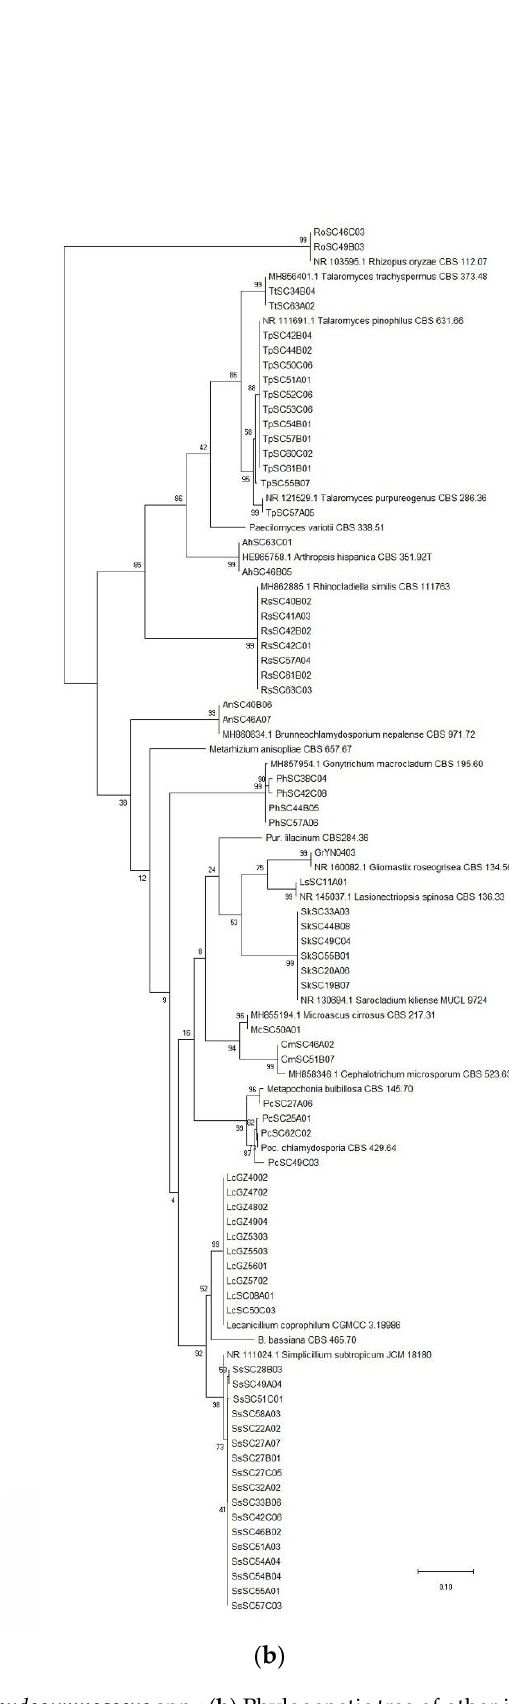
Figure 4. ( a ) Phylogenetic tree of the Aspergillus , Isaria and Pseudogymnoascus spp.; ( b ) Phylogenetic tree of other isolates.